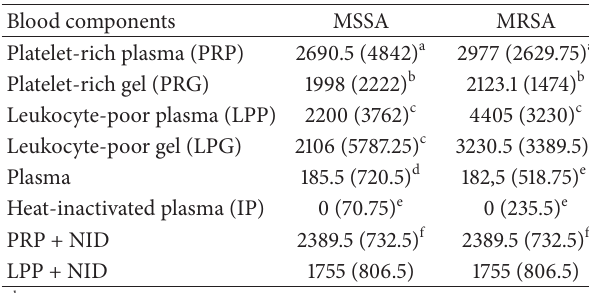
Table 6: PDGF-BB (pg/mL) concentration in every blood compo- nent cultured with either MSSA or MRSA at 6 hours.